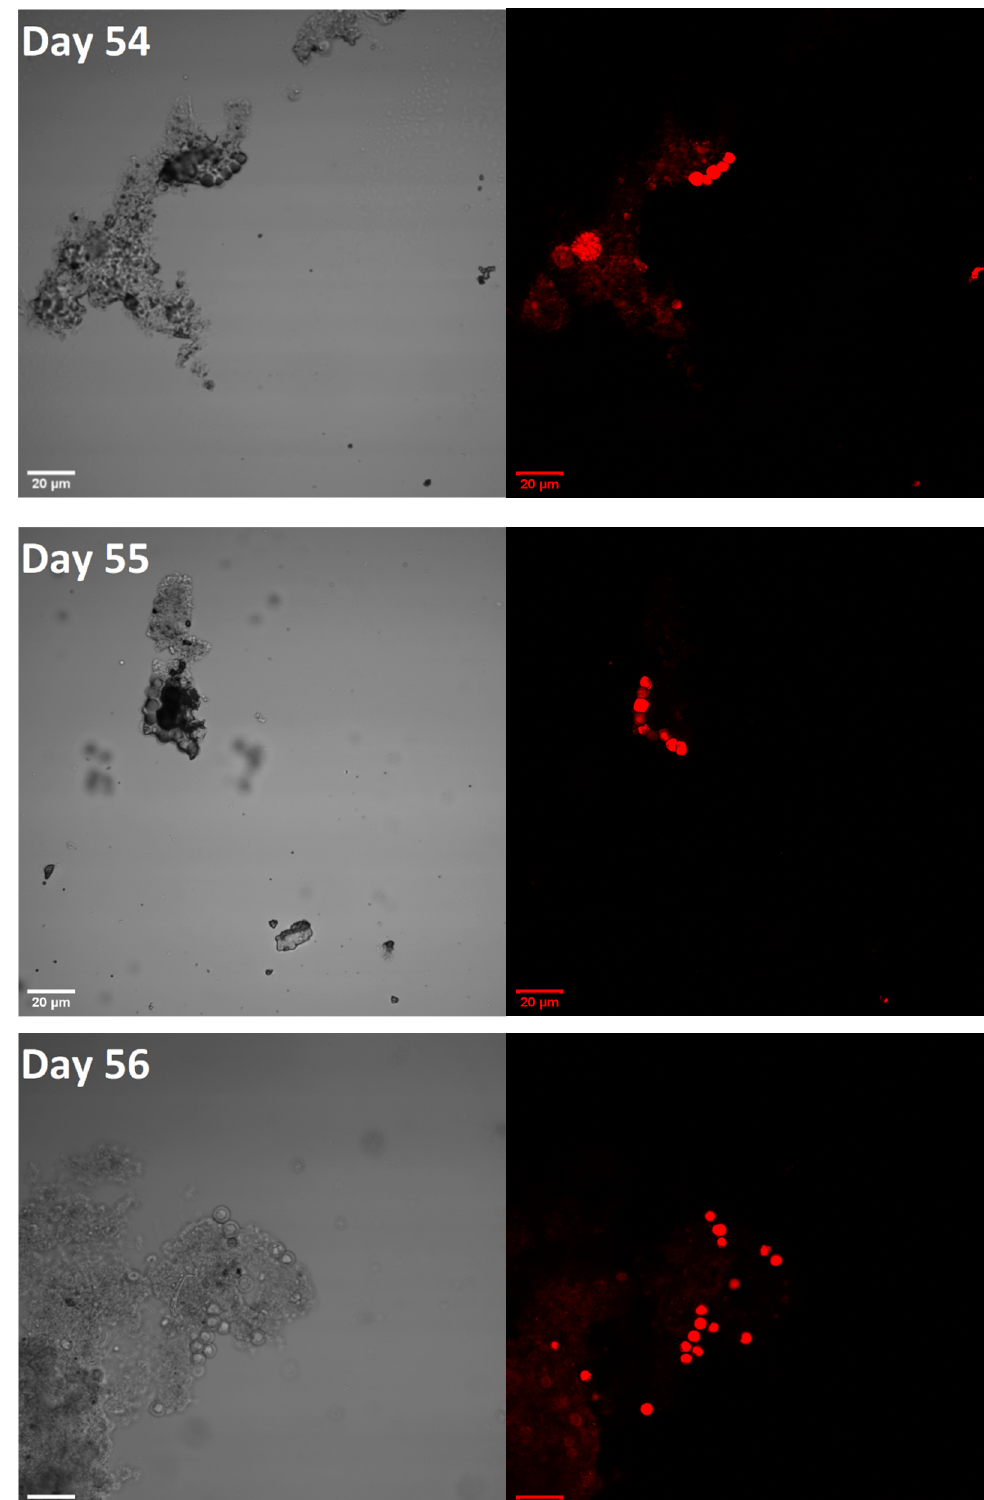
Figure A1. Microscopic images (objective 60×) of samples (batch reactor) observed in visible light and after using Nile Blue A procedure with red filter and blue laser excitation. Both photos were taken on day 66 of batch process and show variability in structure of PHB granules.